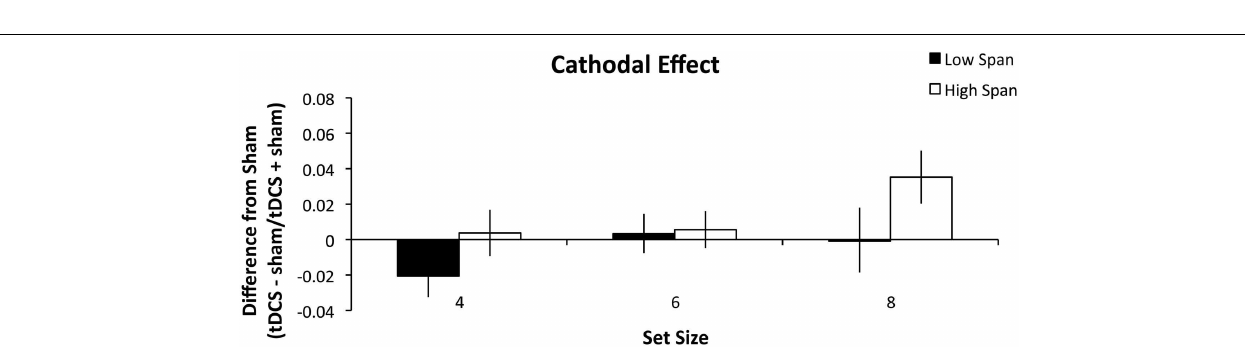
FIGURE 3 | Experiment 2 results. The difference indices for anodal tDCS onWM accuracy. Error bars represent the SEM.